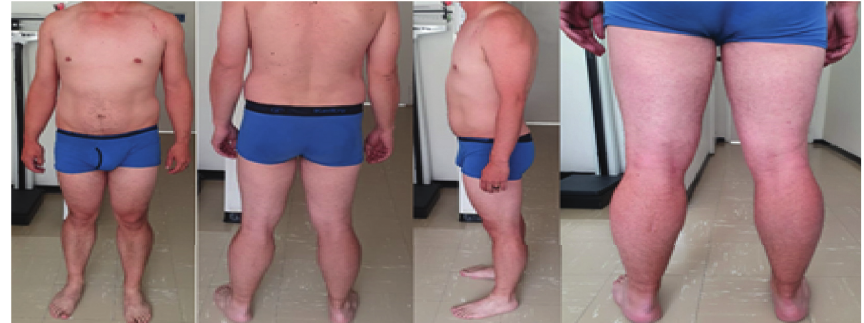
Figure 1: Clinically evident gastrocnemius hypertrophy. Normal muscular trophism in the rest of the